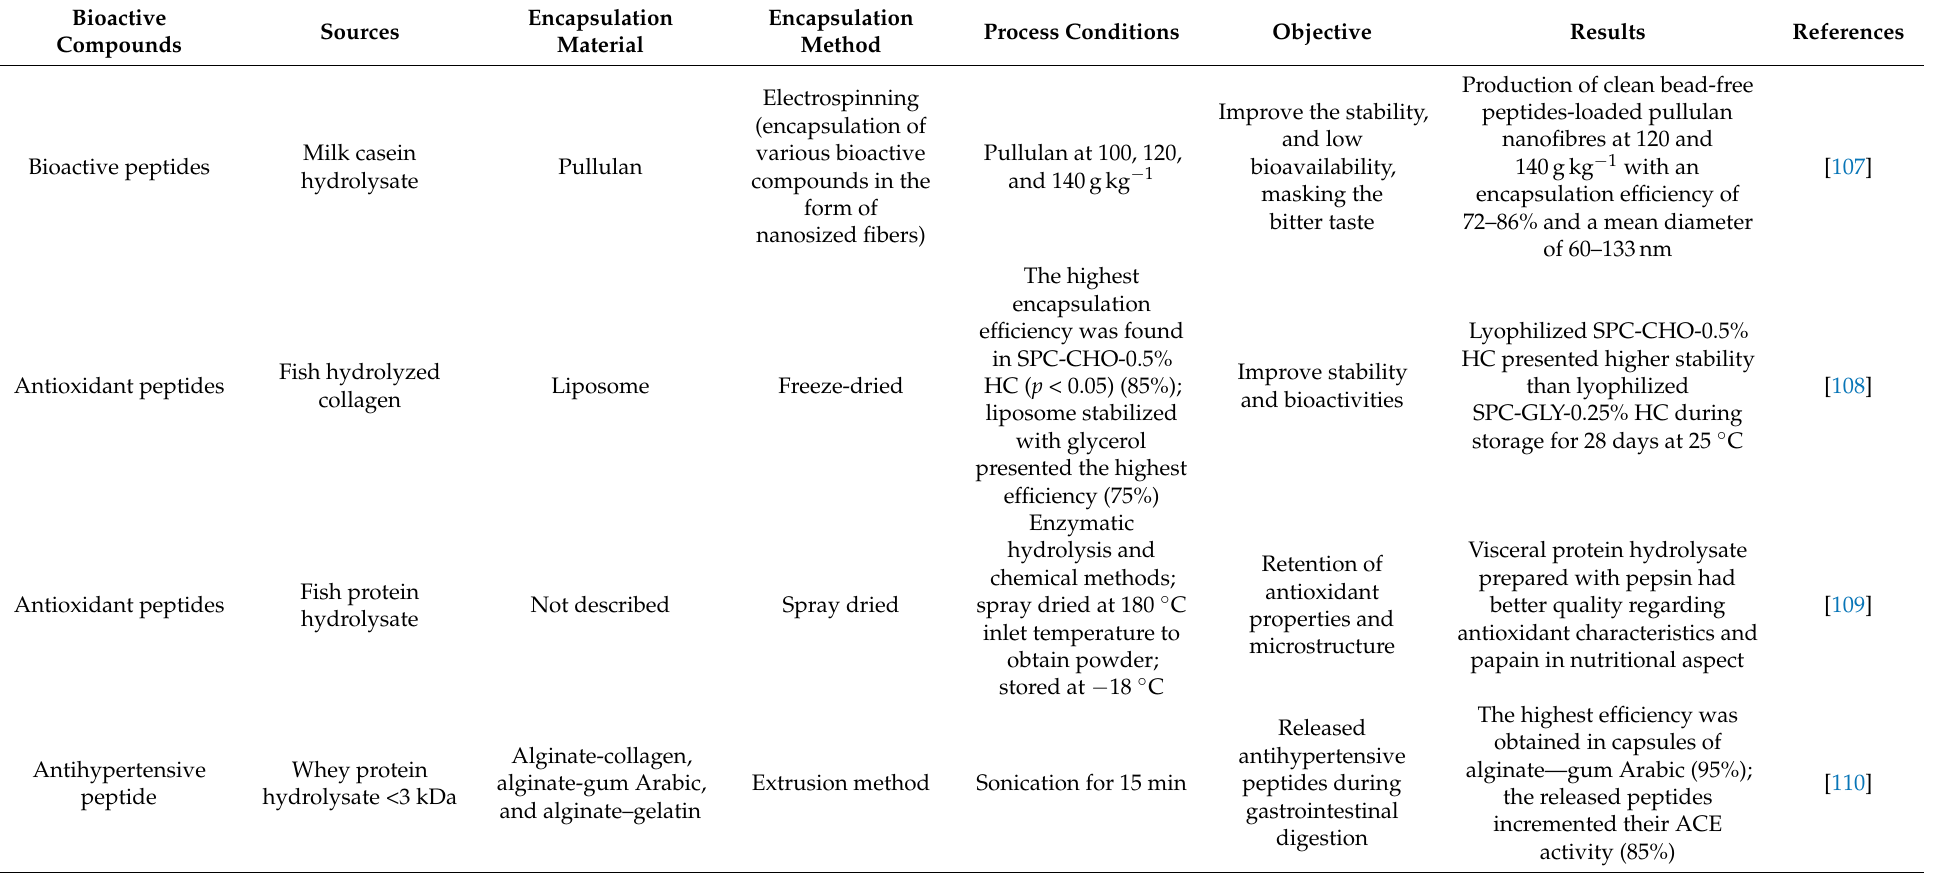
Table 2. Recent studies on encapsulation of bioactive peptides, fatty acids from vegetable oils, and vitamins